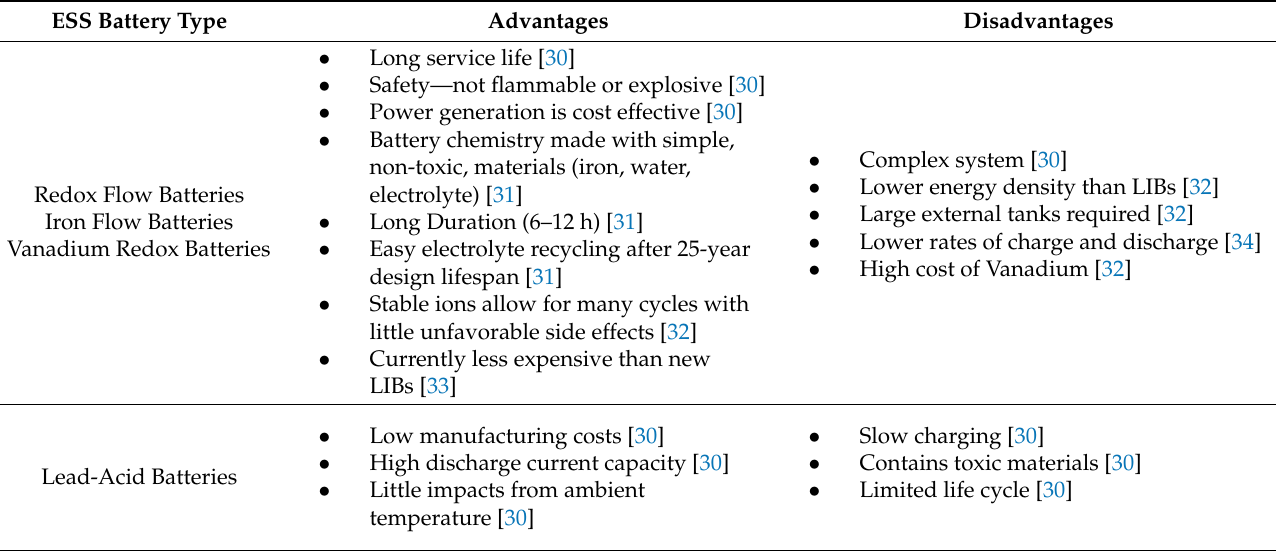
Table 1. Outline of Some Current ESS Battery